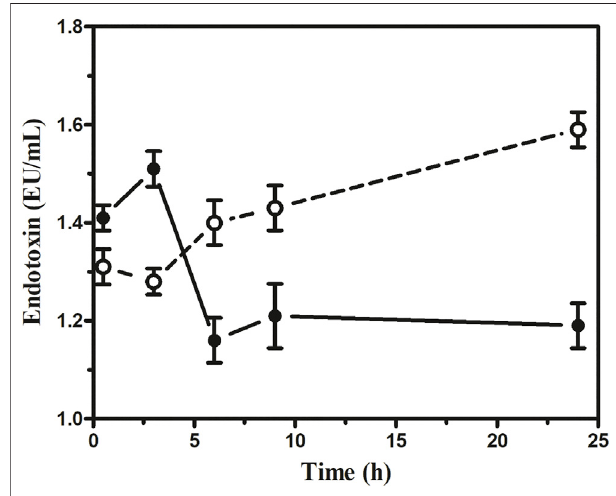
FIGURE 8 | Assessment of endotoxin at the different dosages of phage cocktail given 6 h after bacterial challenge. The open circle ( ○ ) denotes (1 × (cid:129) 10 12 PFU/mouse), and the closed circle ( ) denotes (1 × 10 5